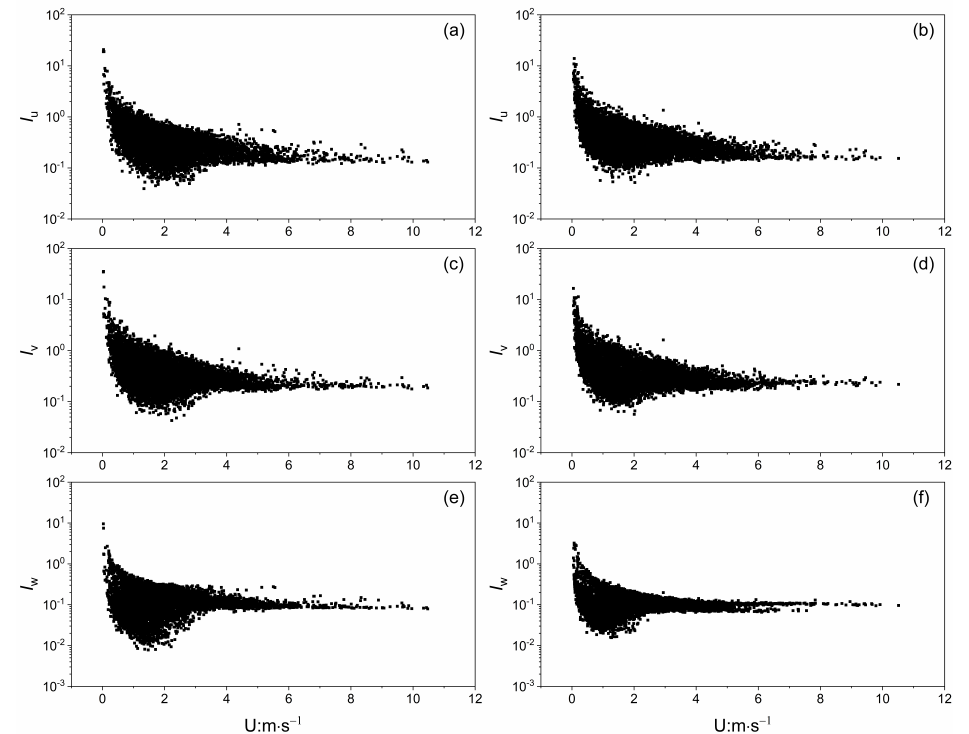
Figure 1. ( A ) Simplified tectonic and geomorphological map of the Tibetan Plateau and its adjacent Figure 5. Relationship between the turbulence strength and wind speed at the PV plant (left: ( a , c , e )) and the reference site areas. The black rectangle shows the location of Figure 1B. ( B ) Topographic map of the Ordos Block and (right: ( b , d , f )), U is the horizonal wind speed. Remote Sens. 2020 , 12 , 4188 its adjacent areas; reported are the major faults and the Yellow River course showing on. The yellow shaded areas show the locations of the Cenozoic sedimentary basins. The sedimentary basins and the faults are modified from [28]. The white dashed rectangle highlights the localization of Figure 2A and of the study area.